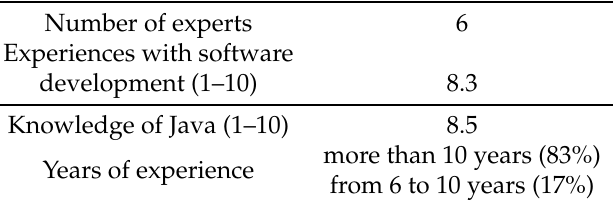
Table 15. Profiles of participating